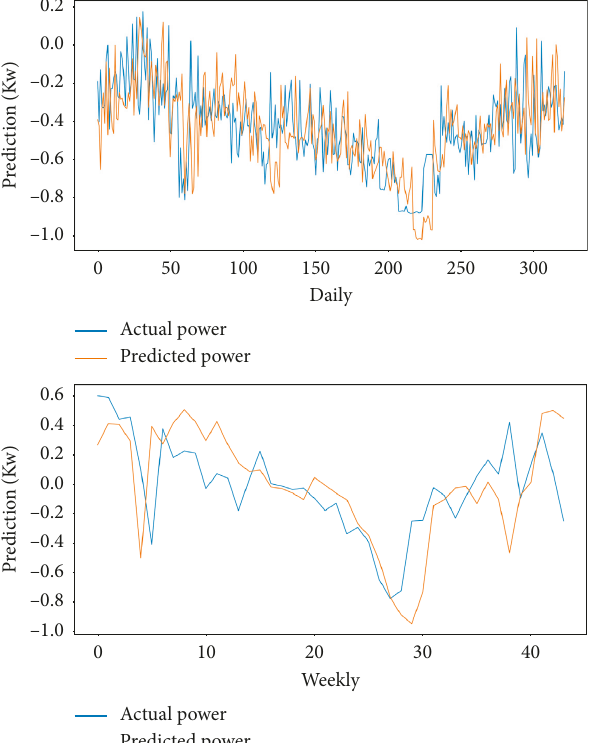
Figure 10: Visual representation of CNN-GRU-based forecasting results considering daily and weekly horizons on the household power dataset.